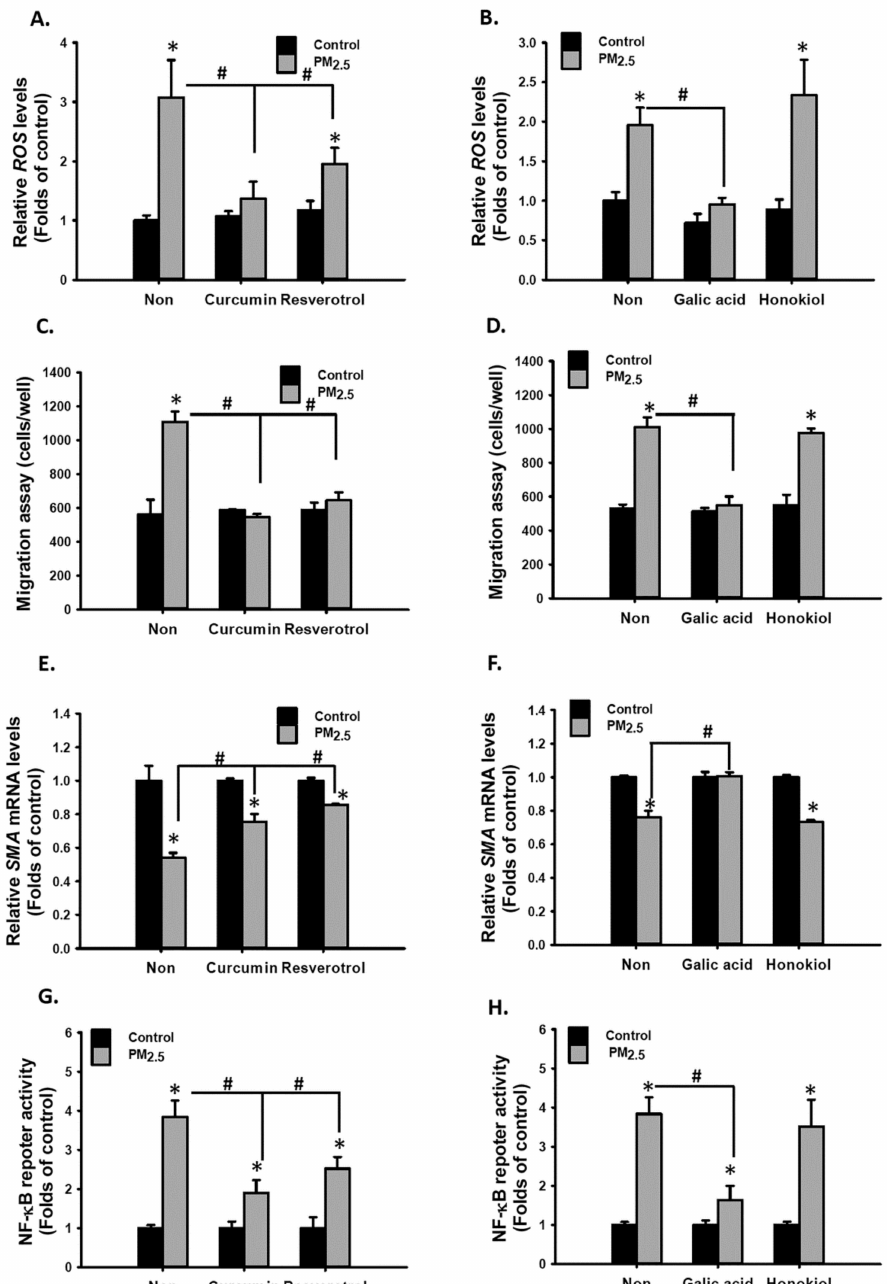
Figure 8. Polyphenolic compounds prevented PM 2.5 -induced oxidative stress, phenotypic changes, and NF- κ B activation in MVSMCs. MVSMCs were treated with d 2 H 2 O or 12.5 µ g/mL PM 2.5 or PM 2.5-10 with and without 5 µ M curcumin, resveratrol, GA, or honokiol for 48 h. The following parameters were determined: ( A , B ) relative ROS levels; ( C , D ) cell migration ability; ( E , F ) relative SMA mRNA levels; ( G , H ) NF- κ B reporter activity. The results are presented as the mean ± SD for the three independent experiments. * p < 0.05, compared with d 2 H 2 O -treated cells. # p < 0.05, compared with herbal compound-treated